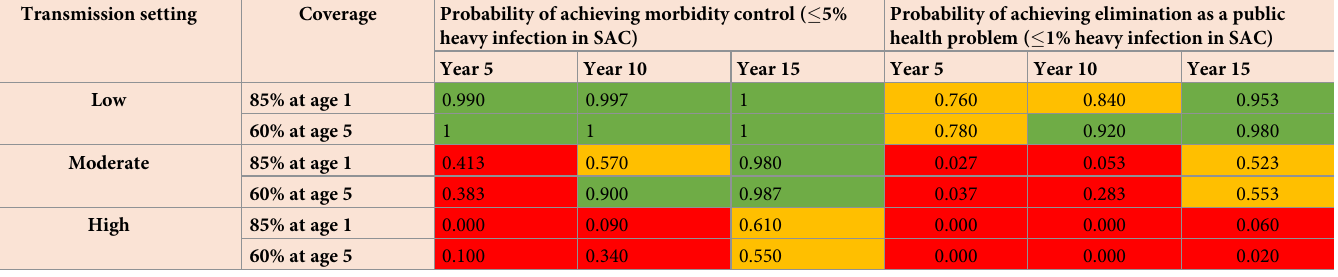
Table 5. Probability of reaching the WHO 1% elimination as a public health problem goal and the 5% SAC 5% morbidity goal for vaccination only with different coverage levels. The duration of vaccine induced protection is set at 20 years. Green shaded areas = probability of reaching target > 0.9, Yellow shaded areas = 0.5 � probability of reaching target < 0.9, Red shaded areas = probability of reaching target < 0.5. Transmission